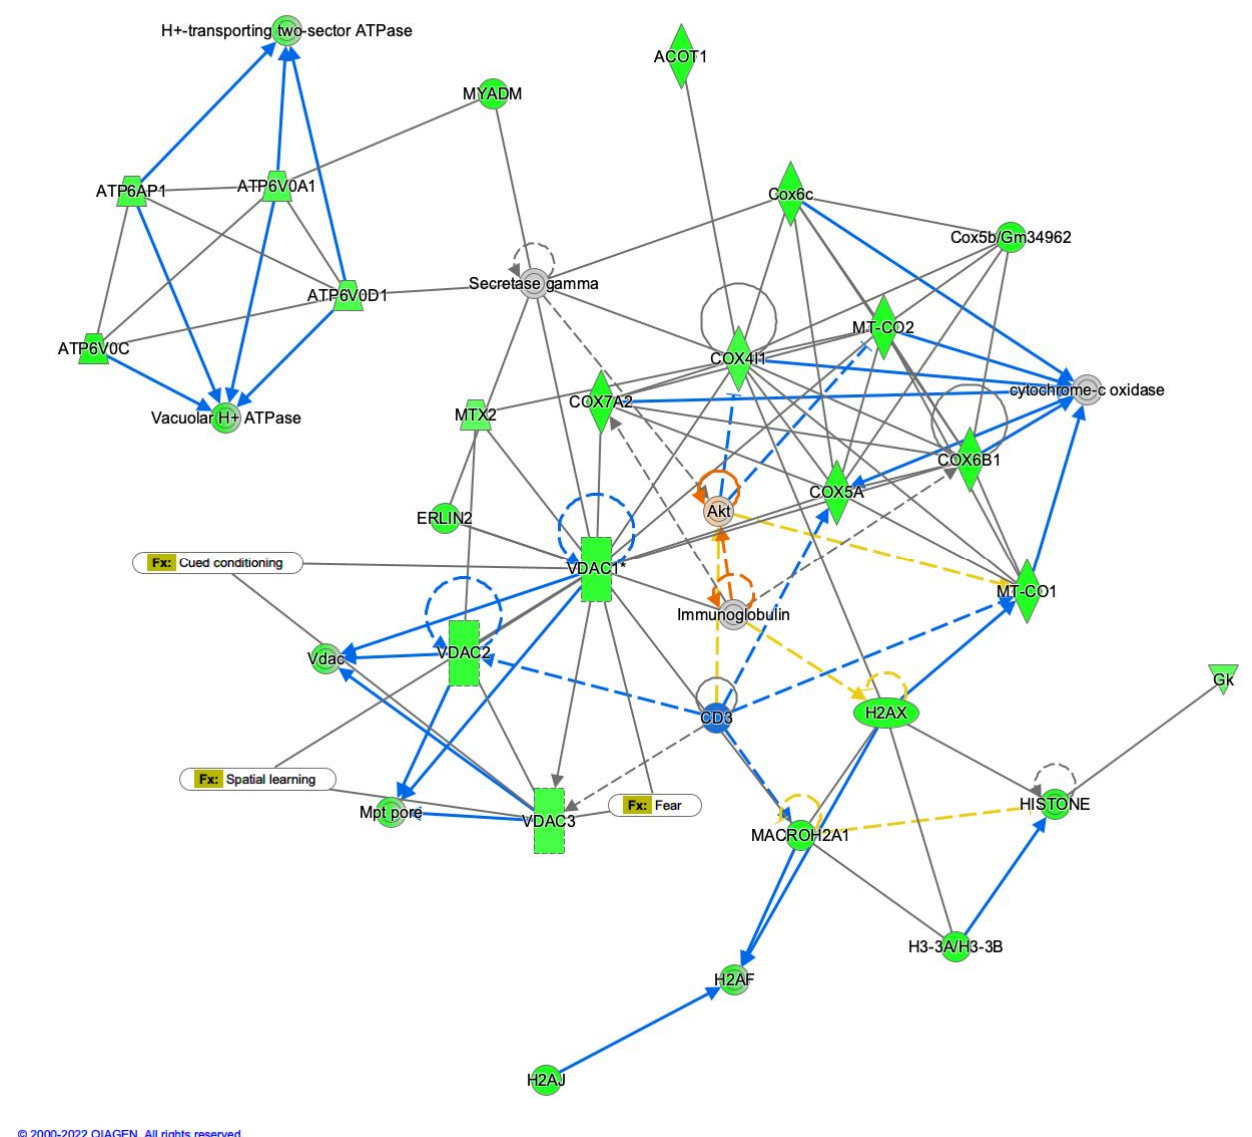
Figure 8. Graphic representation of mouse hippocampus protein network 1, identified by Ingenuity Pathway Analysis (IPA) as being affected by both sham irradiation and 1 H irradiation. Functions associated with the network include developmental disorder, hereditary disorder, and metabolic disease. The network is overlayed with the disease and function tool to display the 3 key molecules involved with behavior. The node color indicates expression value, and color intensity indicates degree of upregulation (red) or downregulation (green). Gray nodes are dataset molecules that were not significantly expressed and therefore did not pass the IPA analysis cutoff. Uncolored nodes were not part of our dataset but were incorporated into the pathway based on evidence stored in the Ingenuity Knowledge Base. Known direct and indirect interactions between network proteins, as well as the direction of the interaction, are indicated by arrows or blocked lines.